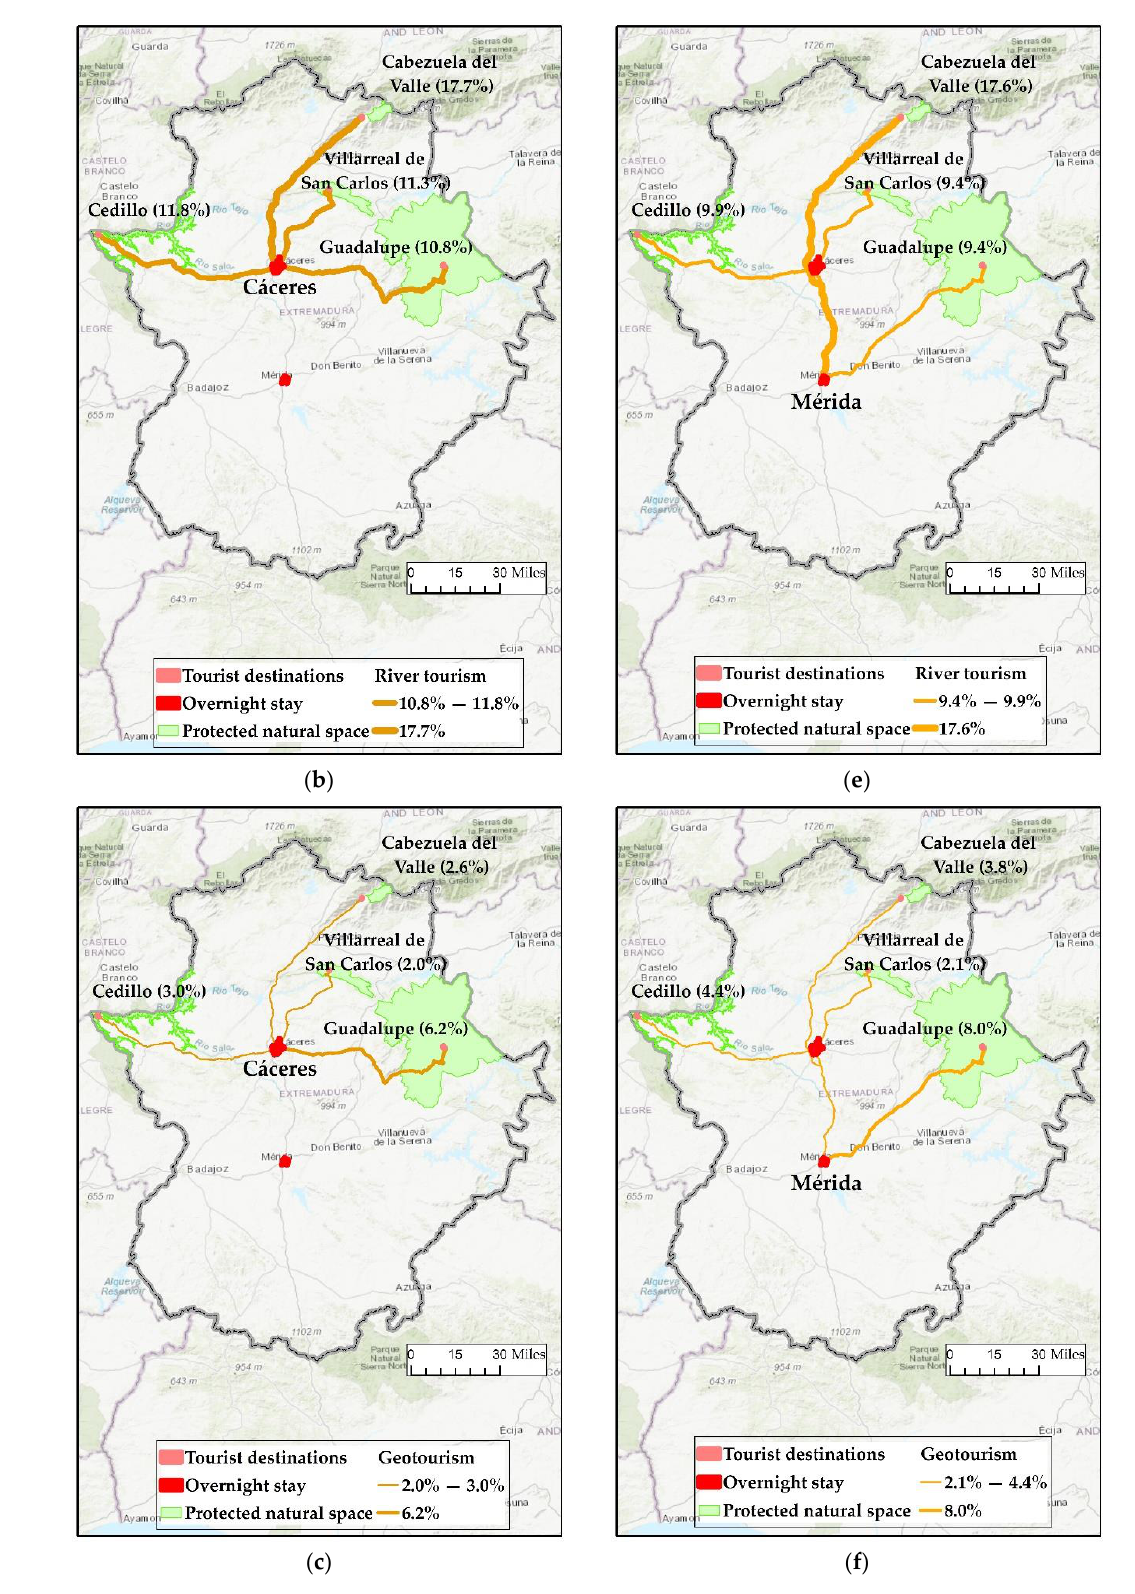
Figure 6. Tourist flows according to motivation: ( a,d ) ornithological tourism; ( b,e ) bathing and river tourism; ( c,f ) geotourism.